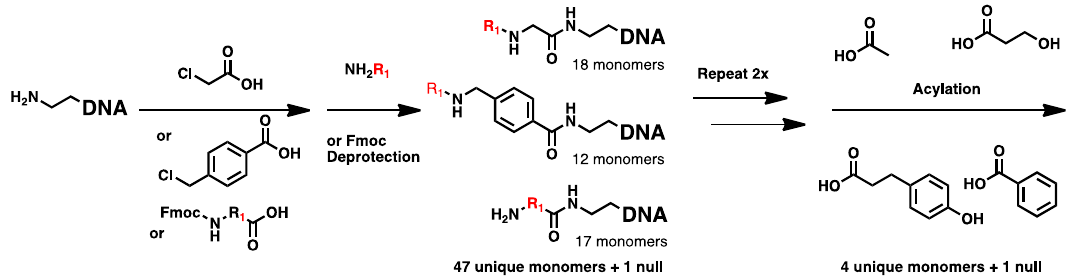
Scheme 1. Construction of DNA encoded library with 5.5 × 10 5 unique members.